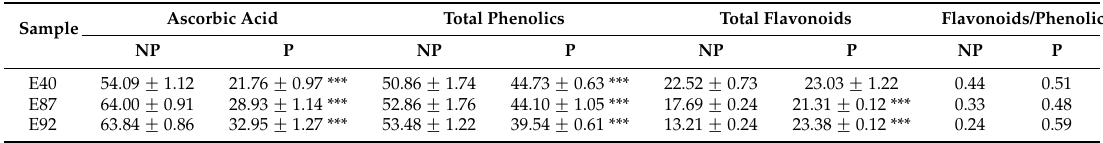
Table 2. Ascorbic acid, total phenolics, total flavonoids content and flavonoids/phenolics ratio in yellow tomato lines before (NP) and after (P) processing.